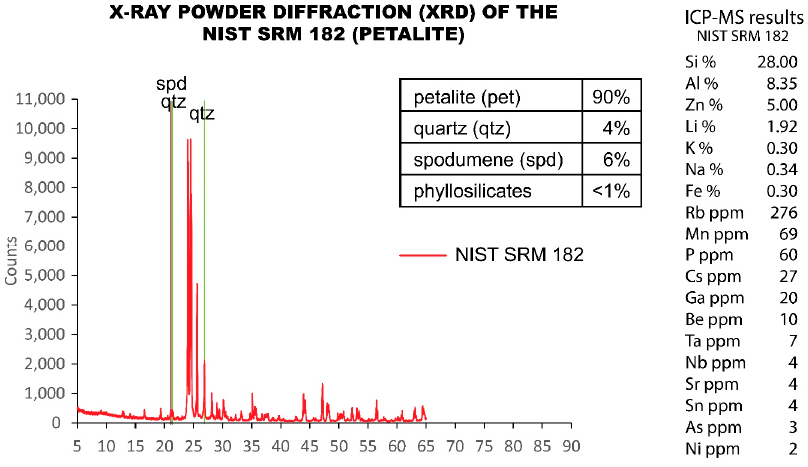
Figure 14. X-ray powder diffraction (XRD) analysis performed on the NIST SRM 182 (petalite) com- pared to the ICP-MS analysis. ICP-MS errors of the quality control samples sent to Actlabs.